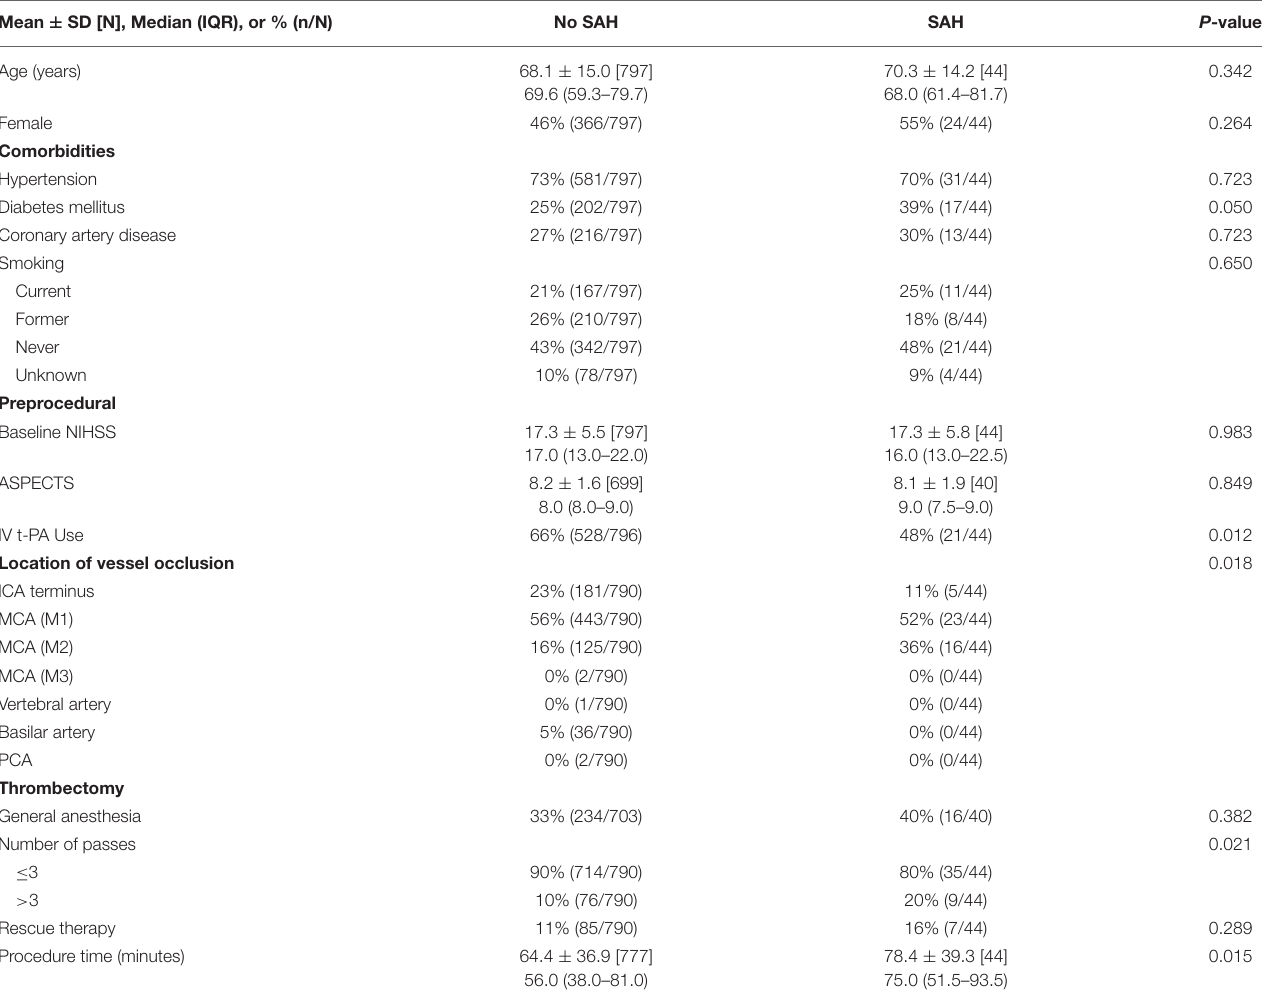
TABLE 1 | Clinical, radiographic, and procedural characteristics in STRATIS ( N = 841). Mean ± SD [N], Median (IQR), or % (n/N)